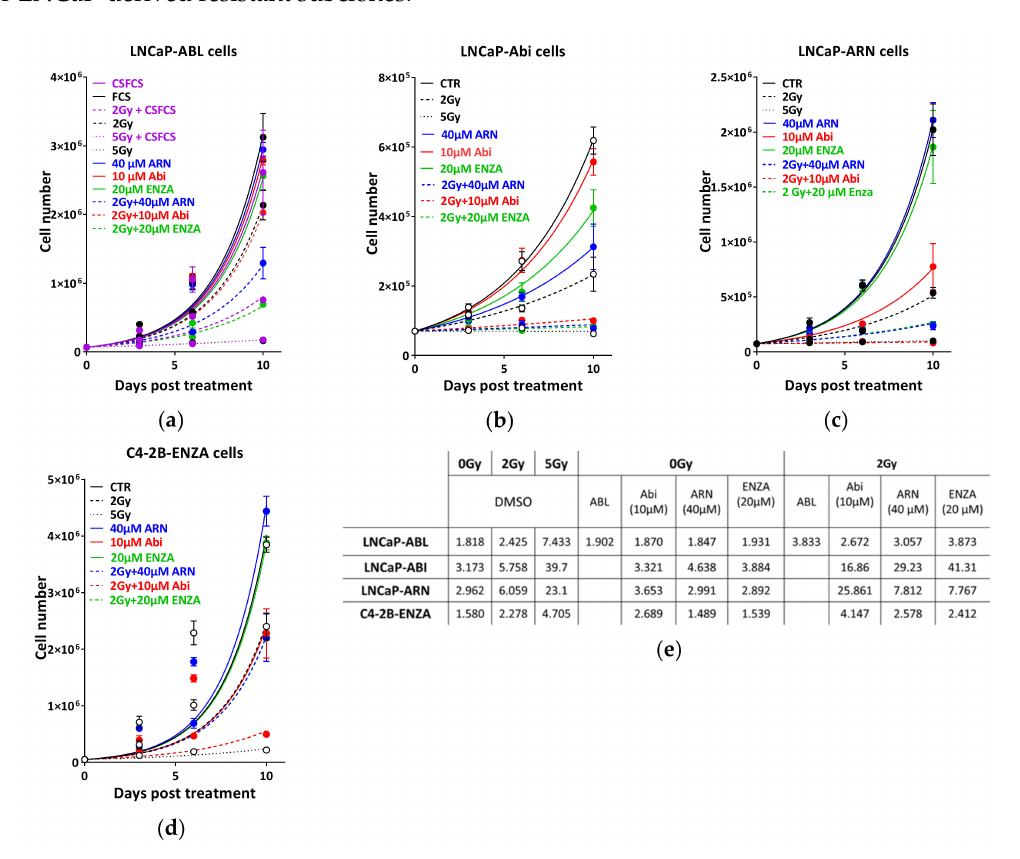
Figure 6. Second generation ADT potentiates the cytotoxicity of ionizing radiation in castration resistant PCa cells. Cell number was determined on days 0, 3, 6 and 10 post treatment with the indicated treatments in LNCaP resistant sublines, to either ( a ) hormone ablation (LNCaP-abl), ( b ) abiraterone acetate (LNCaP-abi), or ( c ) apalutamide (LNCaP-ARN509), as well as ( d ) enzalutamide resistant C4-2B subclone (C4-2B-ENZA). ( e ) Cell-doubling time was calculated for each treatment by fitting exponential growth curves using GraphPad Prism 7. Shown are means ± SEM of at least three independent